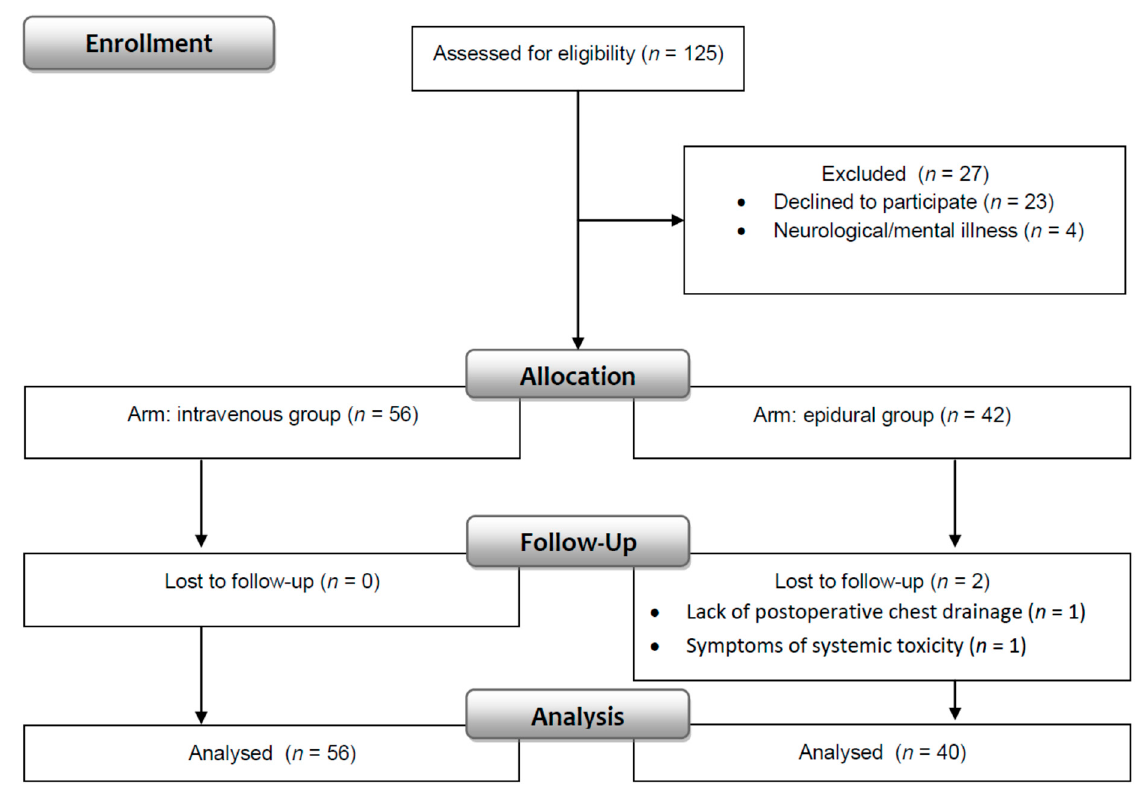
Figure 2. Consort flow diagram.